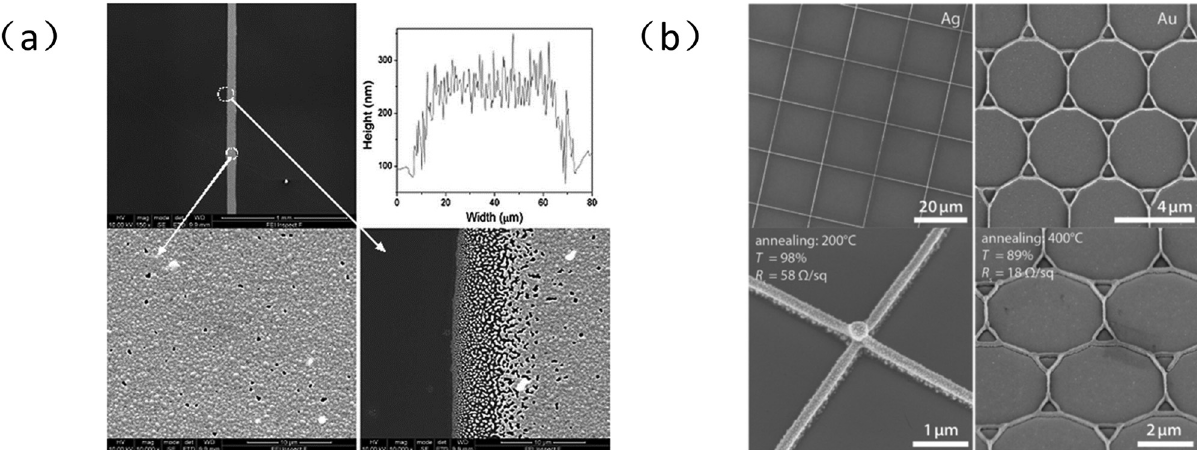
Figure 10: ( a ) Scanning electron microscopy image of printed silver traces on a silicon substrate after curing and cross - sectional pro fi le measured by atomic force microscope. Reproduced from ref. [ 125 ] with permission from American Institute of Physics. ( b ) E - jet printed square silver grid electrode and gold grid electrode. Reproduced from ref. [ 132 ] with permission from Wiley - VCH